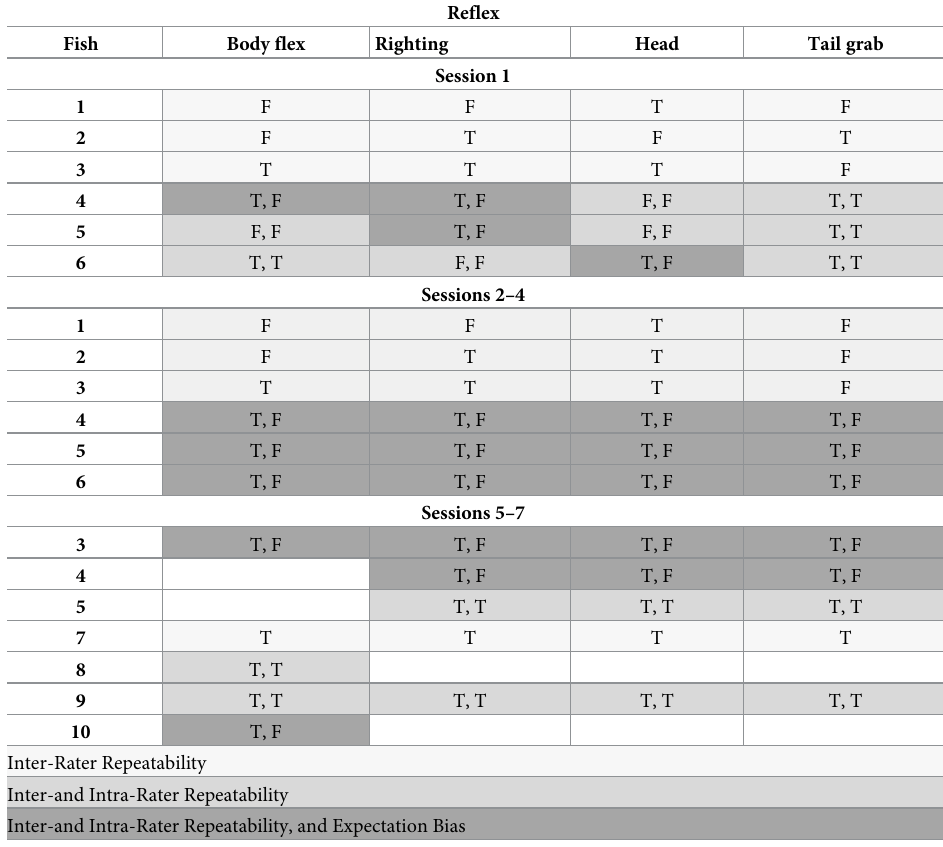
Table 2. Schematic representation of the treatment (inter-rater vs intra-rater repeatability, with or without expec- tation bias; see shading) assigned to 36 video clips (each < 30 s in length) of a given fish’s reflex response per scor- ing